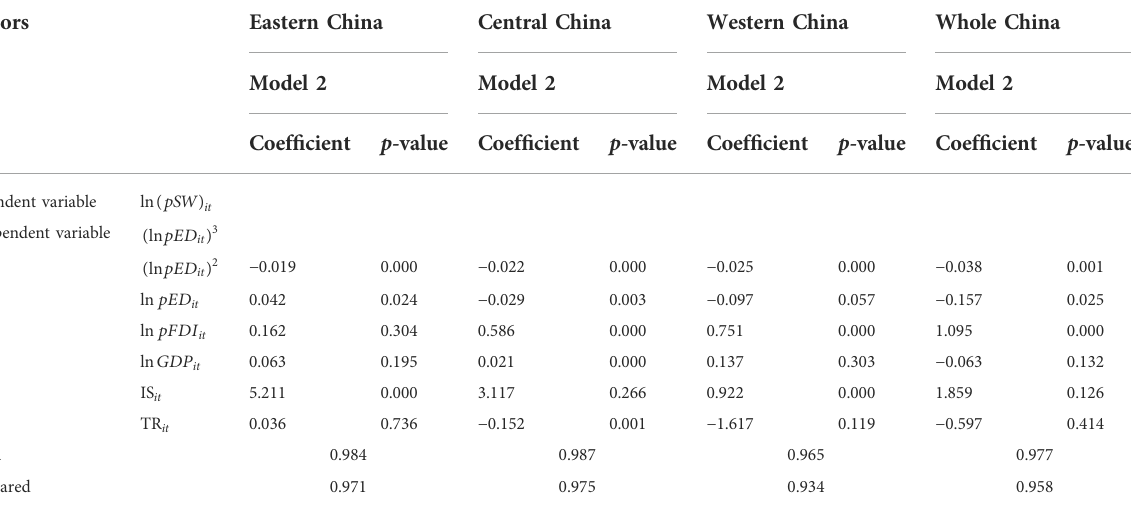
TABLE 11 The weighted DOLS results, Whole &Eastern & Central & Western China, 2001 –